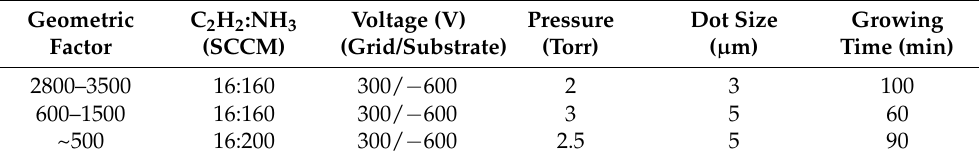
Figure 1. SEM images of CNT cold cathodes: ( a ) geometric factor 1560 (1560-CNT) and ( b ) 550-CNT cold cathode. ( c ) Magnified image of ( a ) at tip region; ( d ) magnified image of ( b ). Table 1. Summary of carbon nanotube (CNT) growing